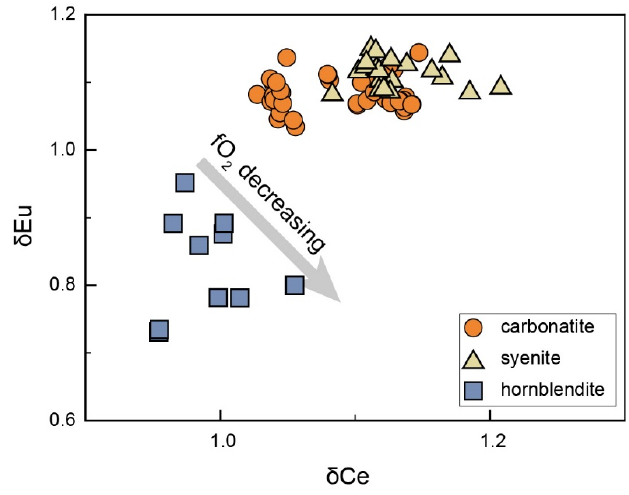
Figure 8. δ Ce vs. δ Eu plot for the apatite in SXD